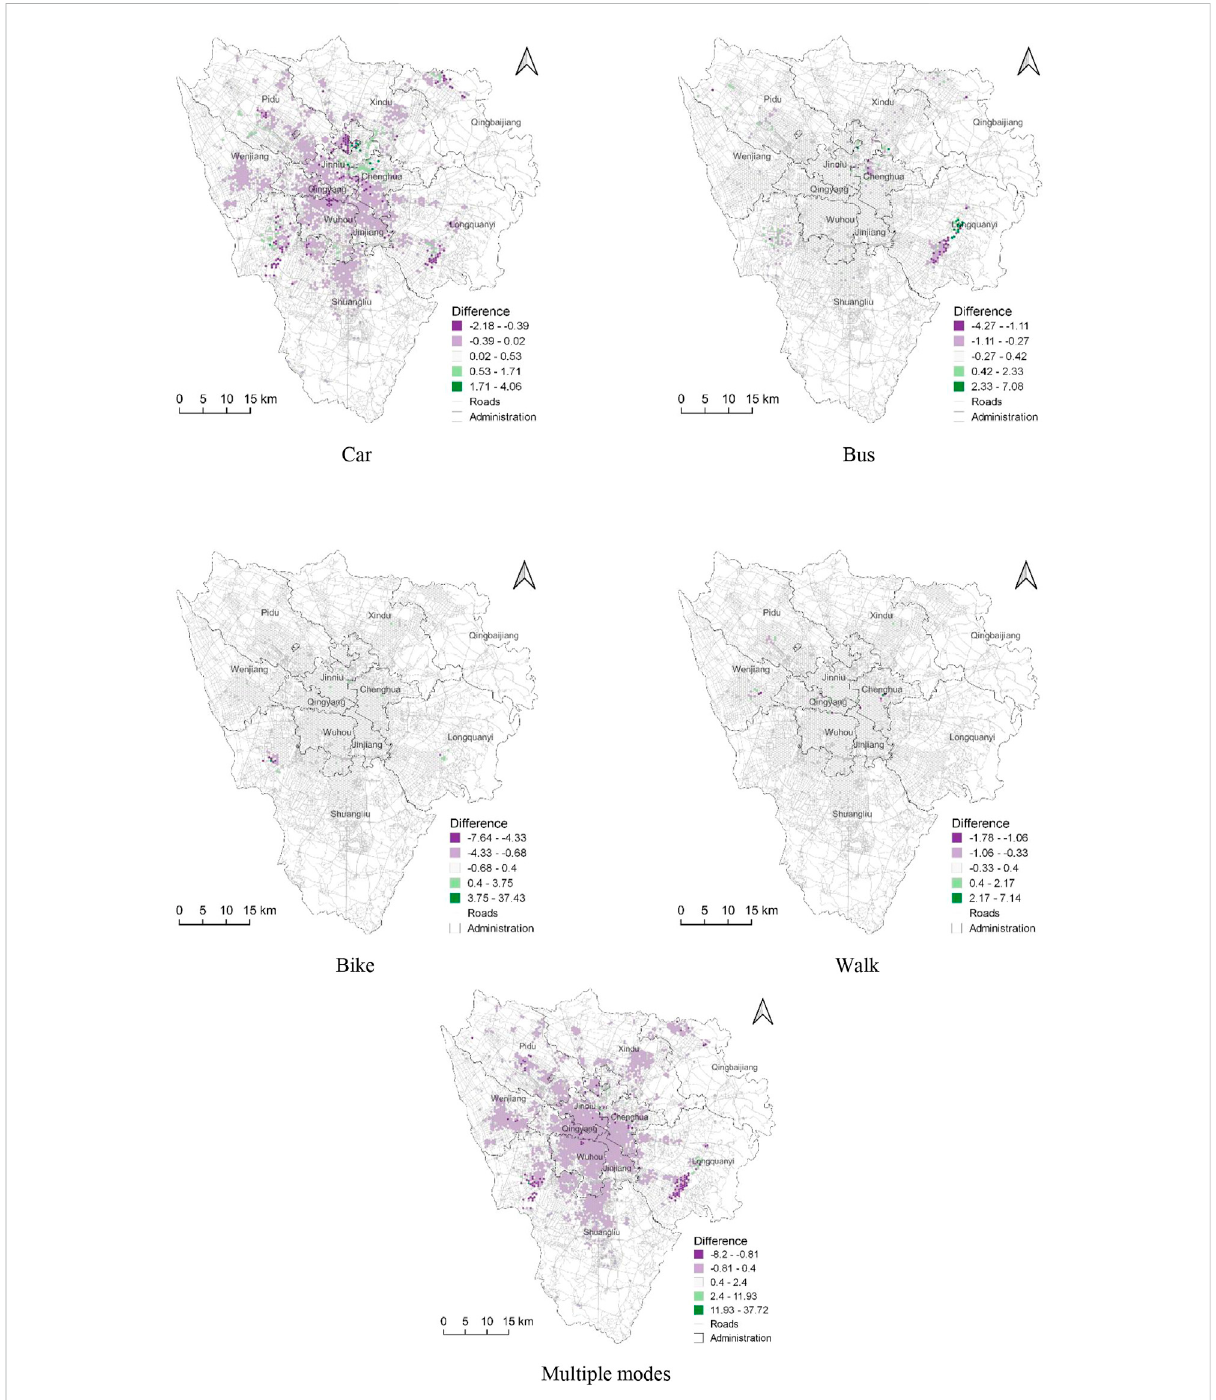
FIGURE 8 Difference of park accessibility by four travel modes between weekdays and